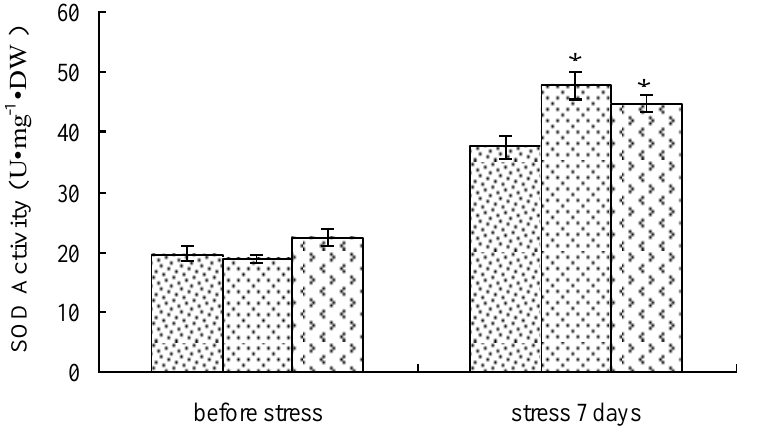
Figure 5. Analysis of superoxide dismutase (SOD) activity in the TaLEA1 transformed and WT poplar lines. SOD activity was determined before stress and after 100 μM CdCl for 7 days. Values are expressed as means ( n = 9 plants); error bars denote SD. * Significant ( t test, P < 0.05) difference compared with WT